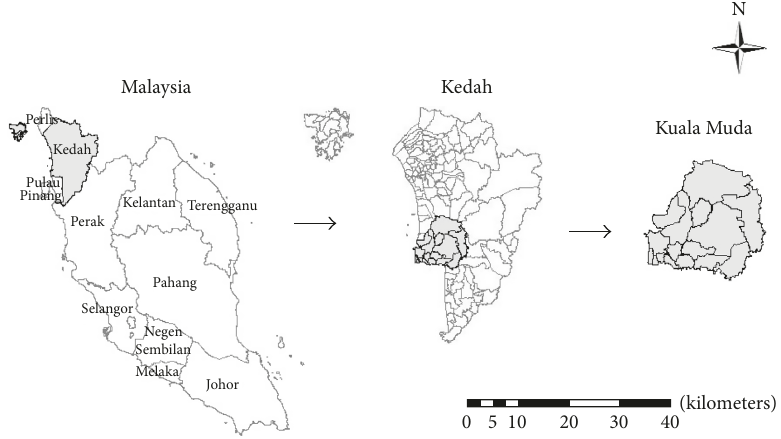
Figure 1: Map showing the study sites located at Kuala Muda, Kedah,